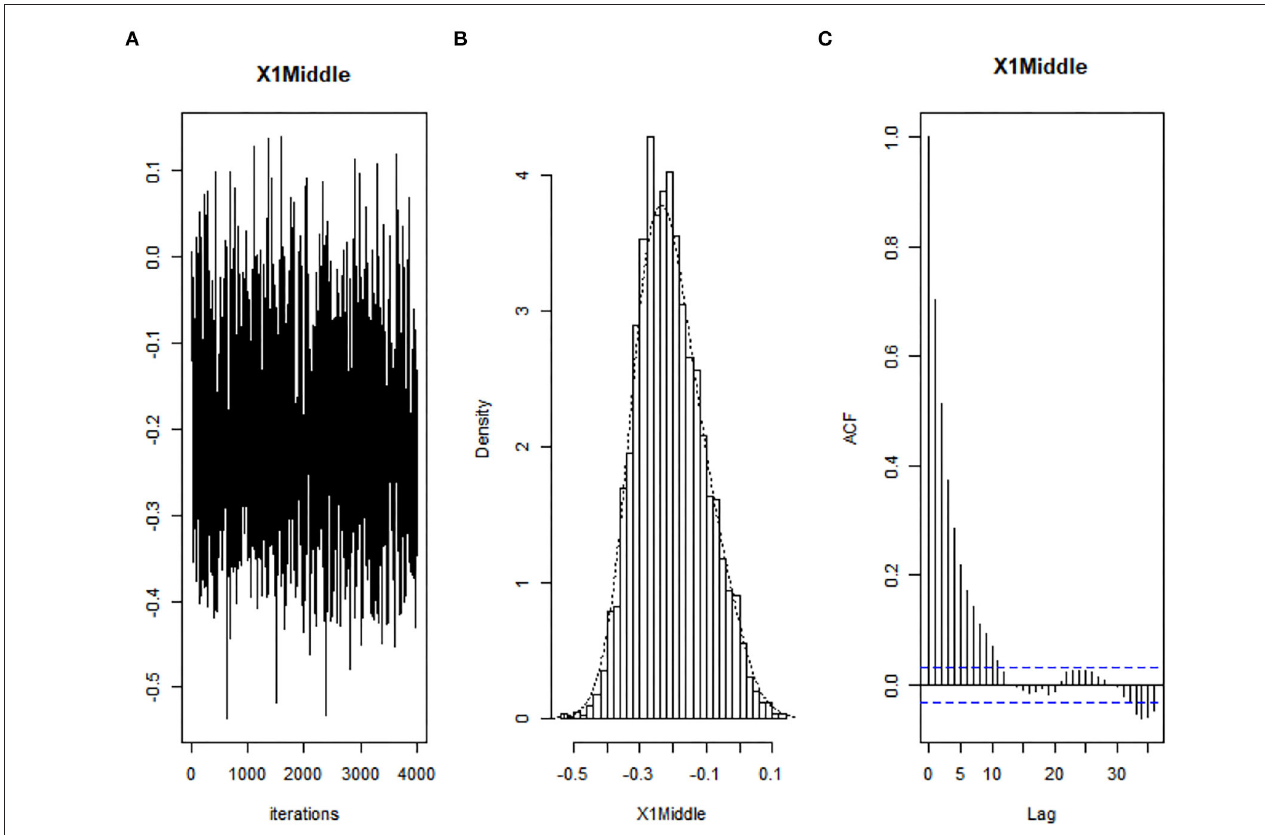
FIGURE 5 | Convergence diagnostics of parameter ˆ β 1 (Middle) at τ (C) autocorrelation